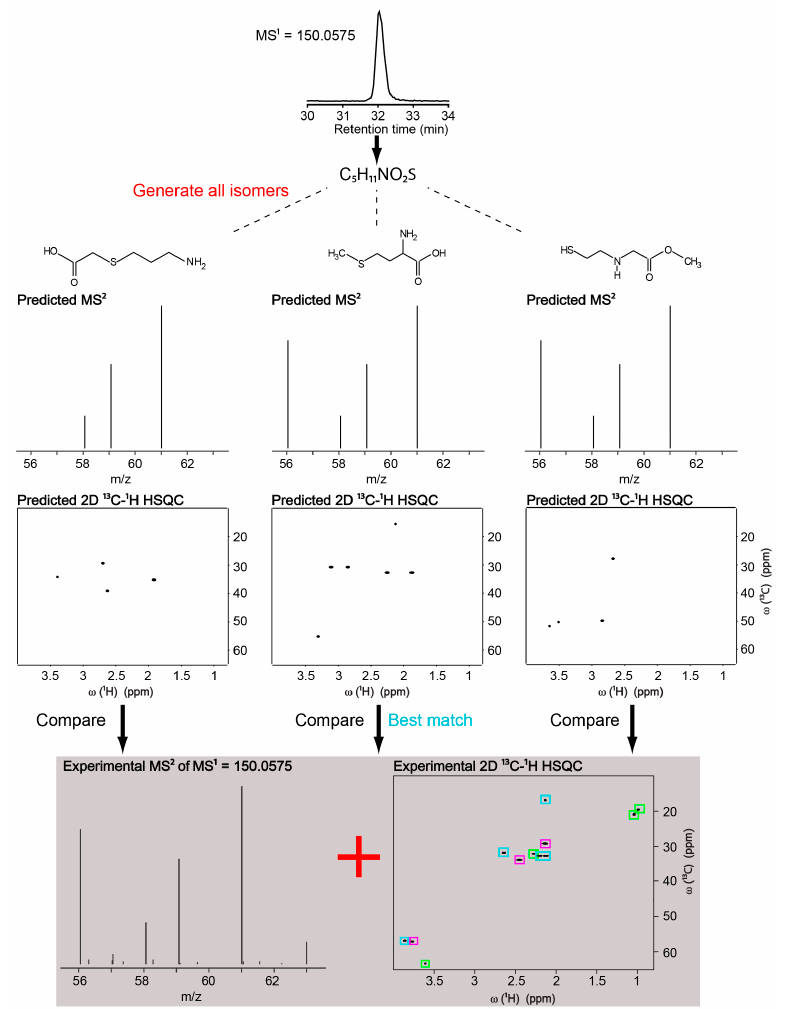
Figure 2. Identification of methionine by the NMR/MS 2 approach in a three-metabolite mixture. Magenta, light-blue and green boxes indicate HSQC peaks of glutamine, methionine and valine, respectively.